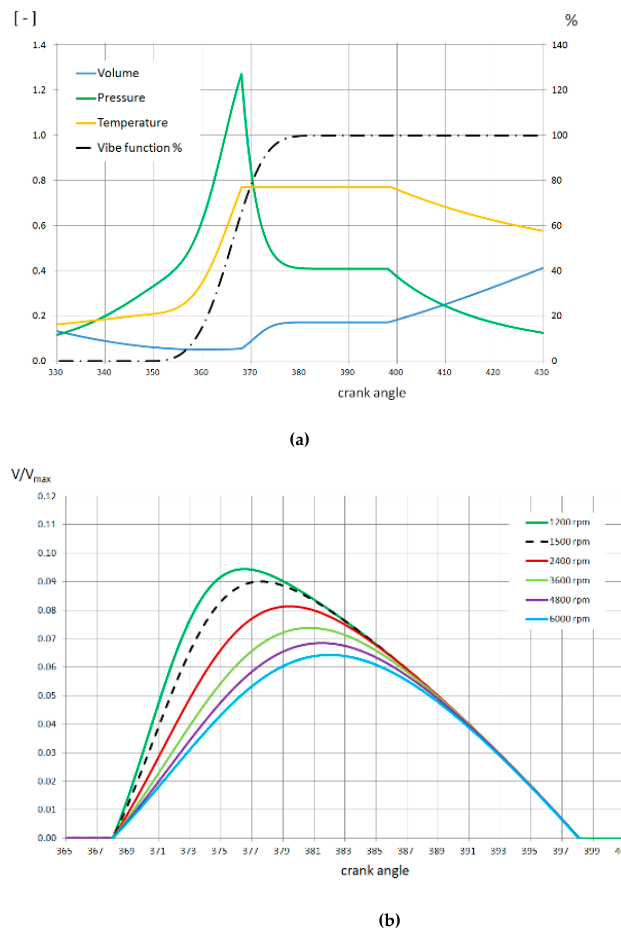
Figure 6. ( a ) A fragment of the parameters V, p, T, and the Vibe function for the proposed theoretical cycle in the form of an open diagram for cr = 20:1, ( b ) the required reaction of the complementing system cr 20:1 as a function of rotational speed (rpm).